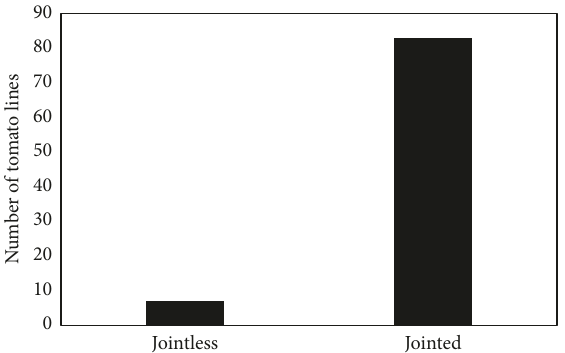
Figure 6: Distribution of ninety-one fresh-market tomato geno- types based on pedicel type.